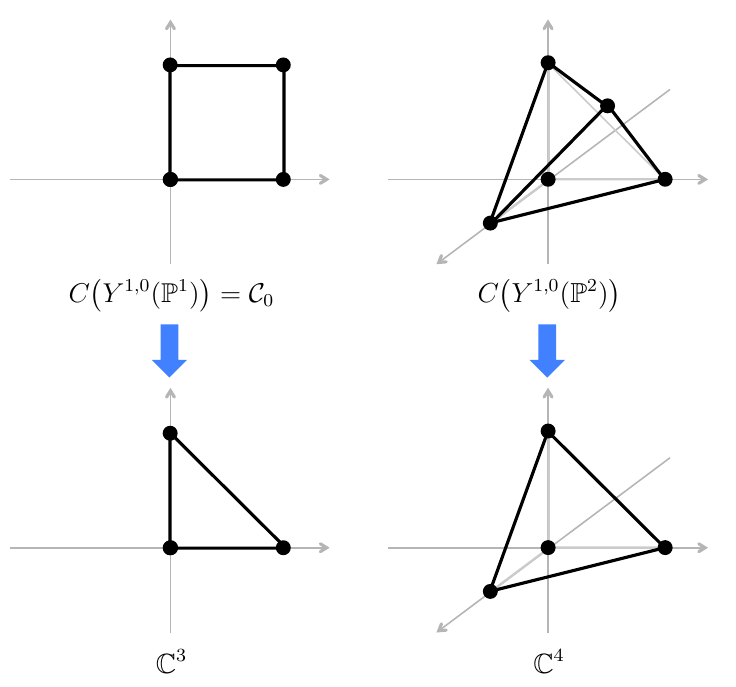
Figure 6 : F ( m ) partial resolution for m = 1 , 2. 0 ⇥ C